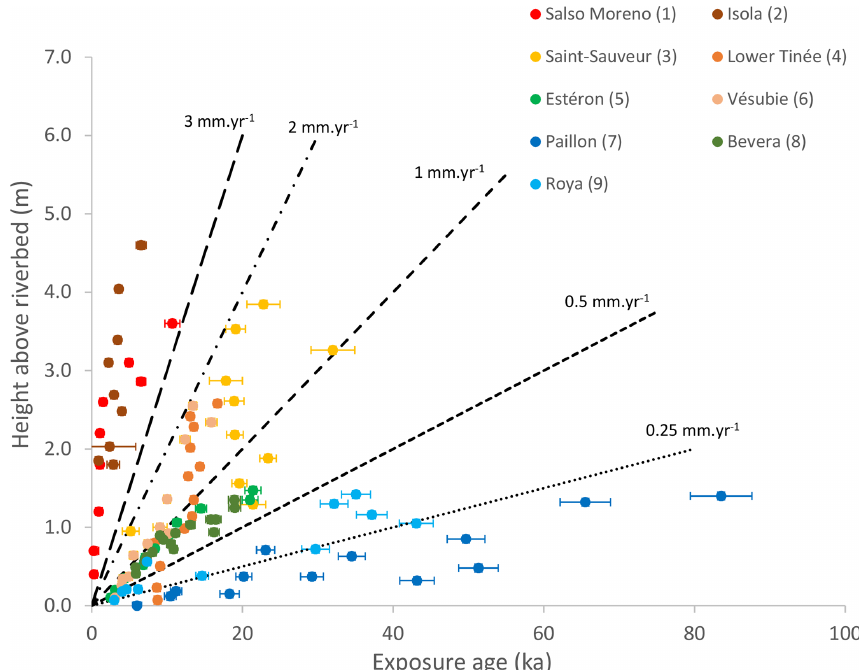
Figure 2. Altitude above the riverbed vs. cosmic ray exposure (CRE) ages and corresponding error bars in samples of river-polished surfaces of the Var, Roya and Paillon catchments (Cardinal et al., 2022; Rolland et al., 2017, 2020; Petit et al., 2019; Saillard et al., 2014). See location of the sites in Fig. 1. Dashed lines indicate constant incision rate curves for